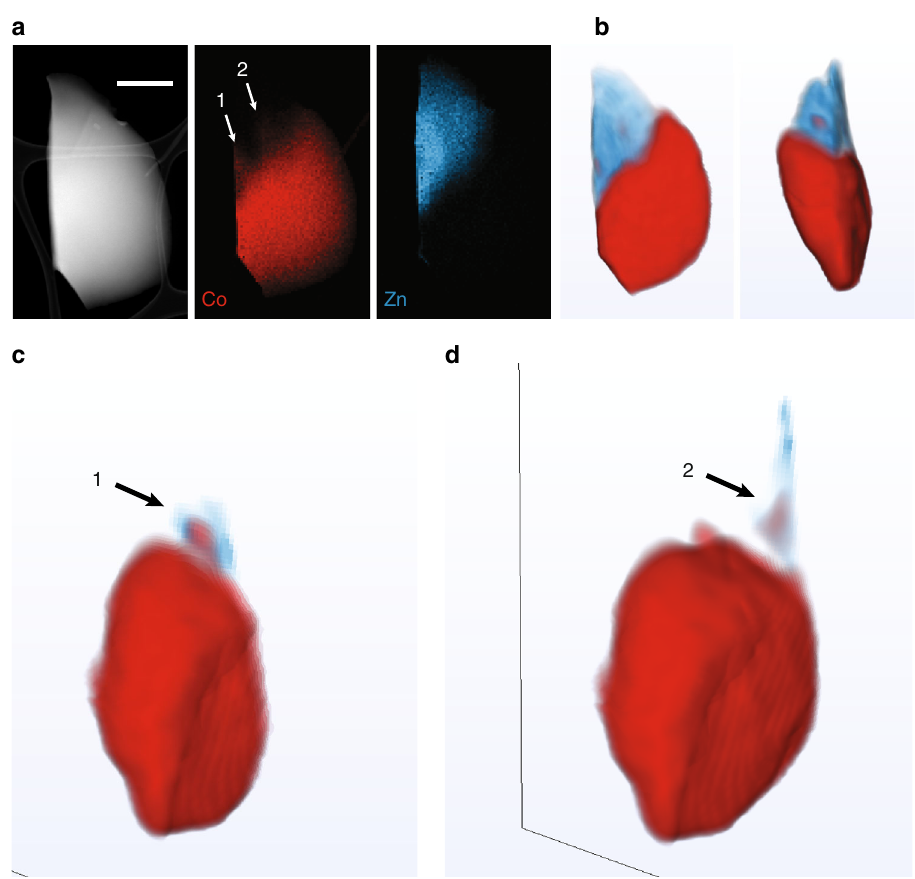
Fig. 5 EDS tomography of a (ZIF-4-Co) 0.5 (ZIF-62) 0.5 glass particle. a Two-dimensional analyses by ADF-STEM showing the particle morphology and EDS chemical maps of Co and Zn. Scale bar is 500 nm. b A volume rendering of the tomographic reconstructions for the Co and Zn signals (two orthogonal viewing directions). c , d Discrete two-dimensional slices from the three-dimensional volume reconstruction for Zn plotted with the transected volume rendering of the Co reconstruction. Two protrusions from the principal Co domain are highlighted with the numbers 1 and 2. These highlight the extent of three-dimensional spatial overlap in Co and Zn in c ,